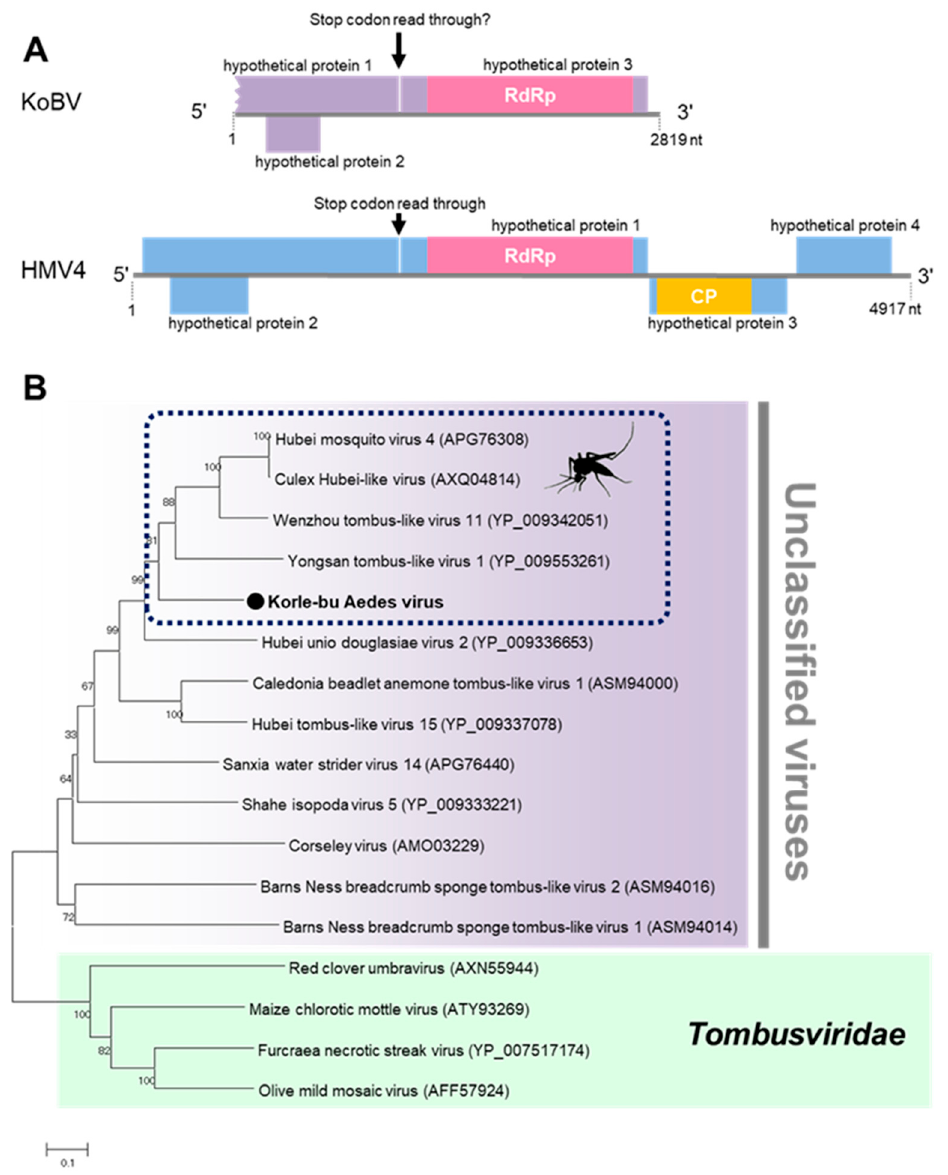
Figure 9. Genetic characterization of Korle-bu Aedes virus (KoBV). ( A ) KoBV genome showing the predicted stop codon read through. ( B ) Evolutionary history of KoBV. Maximum likelihood tree constructed with the conserved amino acid domain of the genome sequence with Genbank accession number LC496785. The conserved domains were extracted using MAFFT 7 online version [27] and the Gblocks program [28]. Bootstrap support values from 1000 bootstrap replicates are indicated on the branches.